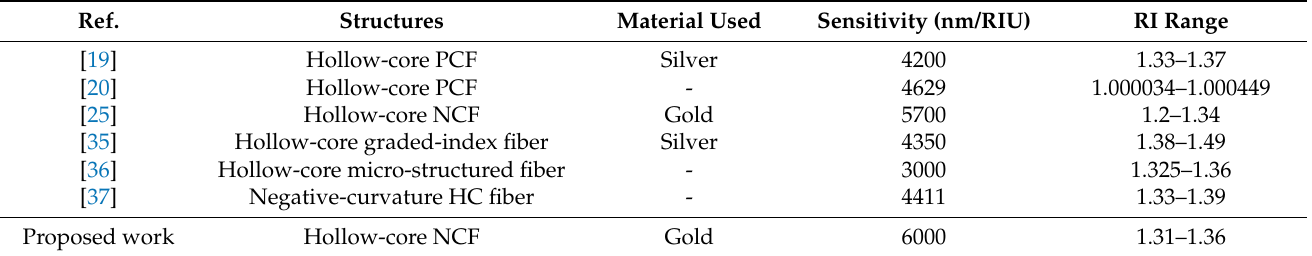
Table 2. Comparative study of the sensor’s performance and sensors in other recent published work.